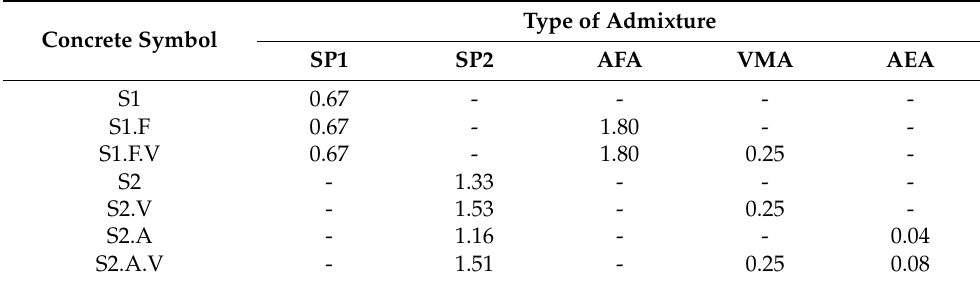
Table 3. The dosage of admixtures by weight of the total binder, % [25].